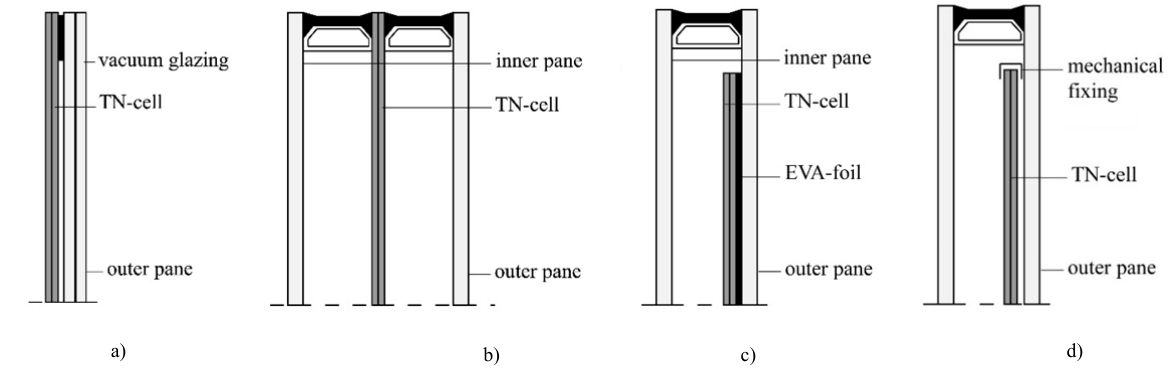
Fig. 2 Possible integration methods of TN-cells into insulating glazing units. Drawings: M. Husser, ILEK